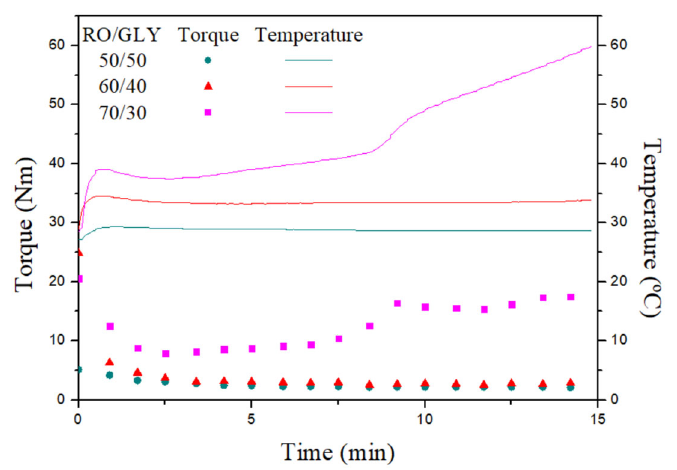
Figure 2. Torque and temperature values for different RO/Gly systems during the mixing stage.